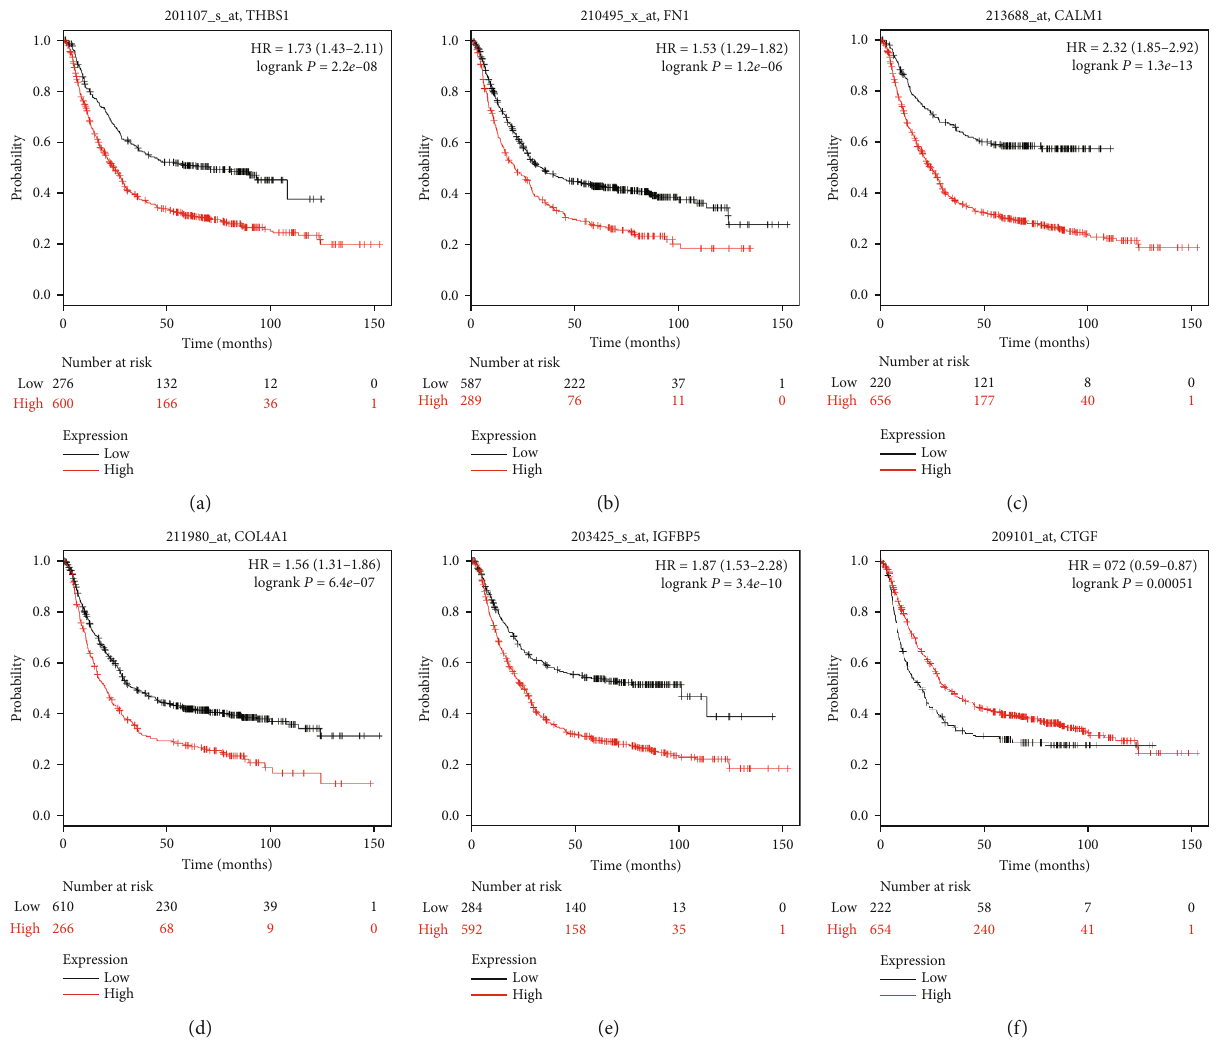
Figure 9: Prognostic curve for the six hub genes. The prognostic signi fi cance of the hub genes in patients with GC determined using the Kaplan-Meier plotter. A ff ymetrix IDs (a) 201107_s_at, (b) 210495_x_at, (c) 213688_at, (d) 211980_at, (e) 203425_s_at, and (f) 209101_at represent THBS1, FN1, CALM1, COL4A1, IGFBP5, and CTGF, respectively. Red lines represent patients with high gene expression, and black lines represent patients with low gene